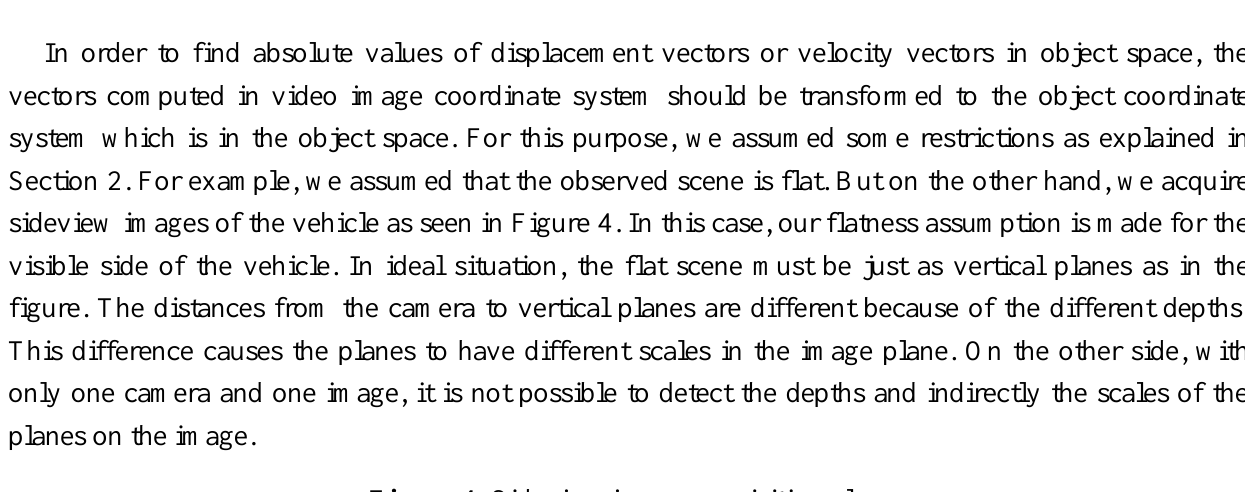
Figure 4. Sideview image acquisition